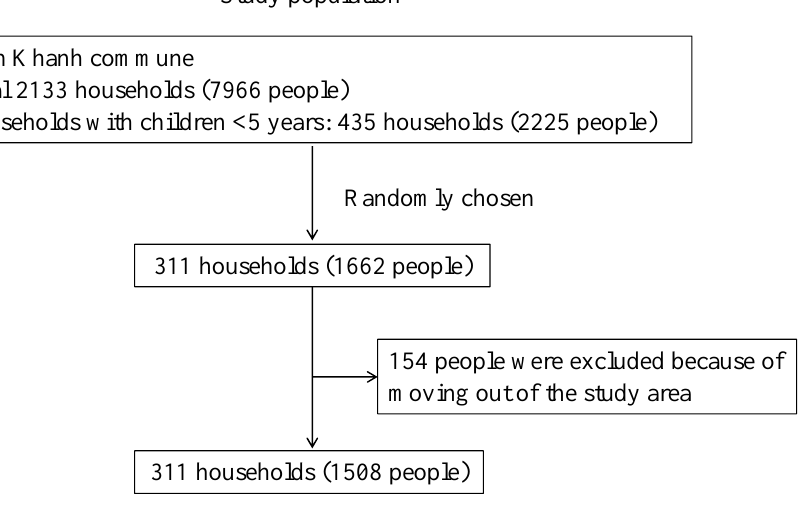
Figure 1. Flow of the participants’ inclusion in the study.